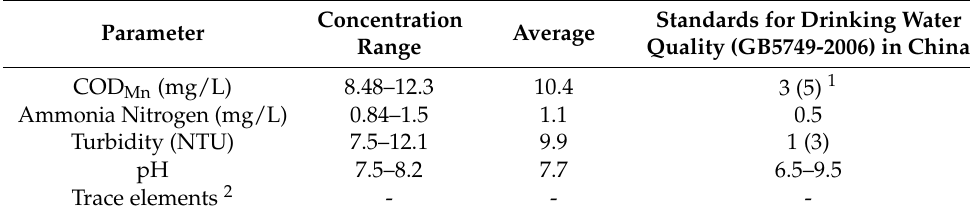
Table 1. Water quality of